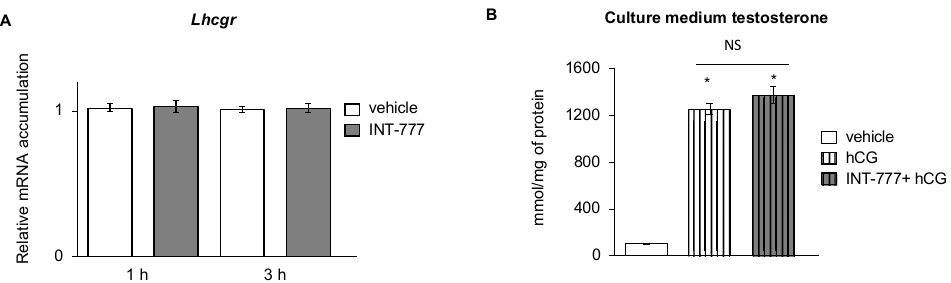
Figure 3. TGR5 did not regulate sensitivity of mLTC1 cells to hCG. ( A ) Relative Lhcgr mRNA accumulation normalized to β -actin in mLTC1 cells treated with vehicle or INT-777 for 1 h or 3 h ( B ) Relative intracellular levels of testosterone, normalized to protein concentration, in mLTC1 cells pre-treated with vehicle (DMSO) or INT-777 for 24 h and then for 2 h with vehicle (NaCl 0.9%) or hCG. n = 9 to 12. Data are expressed as the means ± SEM. Statistical analysis: * p < 0.05 compared to vehicle treated cells. NS: